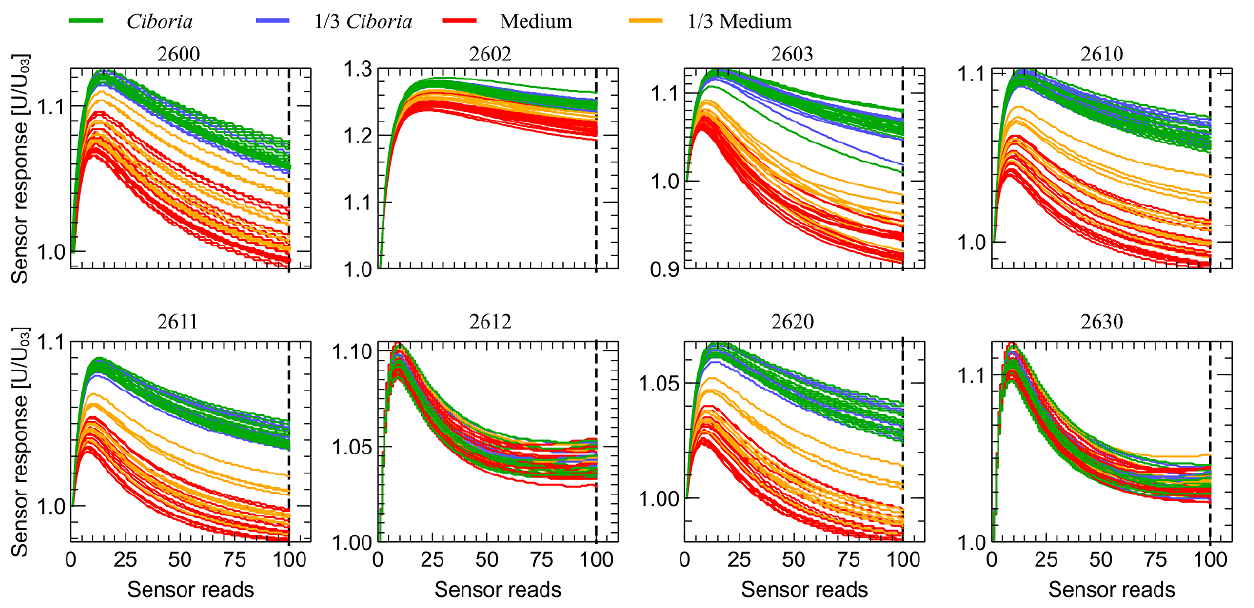
Figure A1. Sensors’ transient response in the third stage of the observation time (after the increase in the sensor heater voltage), versus time elapsed from the moment of voltage increase. The sensor’s response voltage is expressed as normalized by the voltage at the beginning of the stage of observation time U 03 . Variants of the measured samples are marked by color lines. The sensor type is indicated above the subfigures. The vertical dotted line indicates the observation moment at which data presented in Figure A3 is collected.